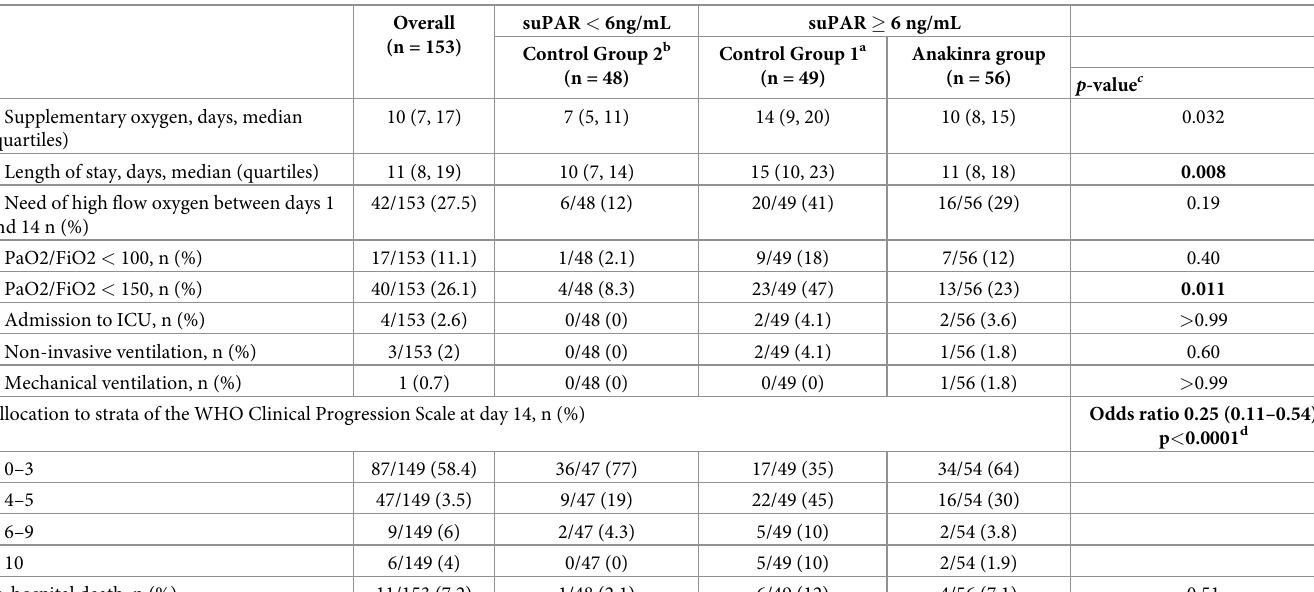
Table 2. Outcomes.